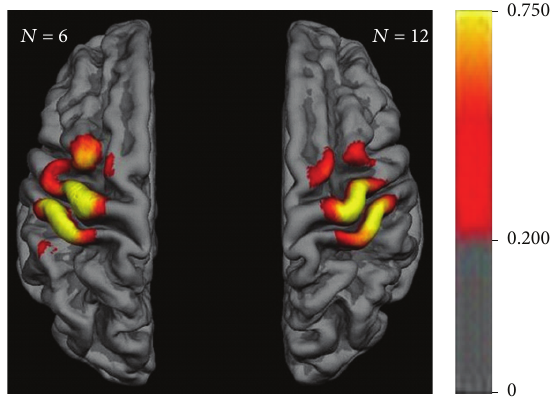
Figure 3: Motor map group data of individual means over time with mean overlap percentage. Color bar indicates percent of sub- jects presenting with MEPs > 50 𝜇 V throughout the experimental sessions.